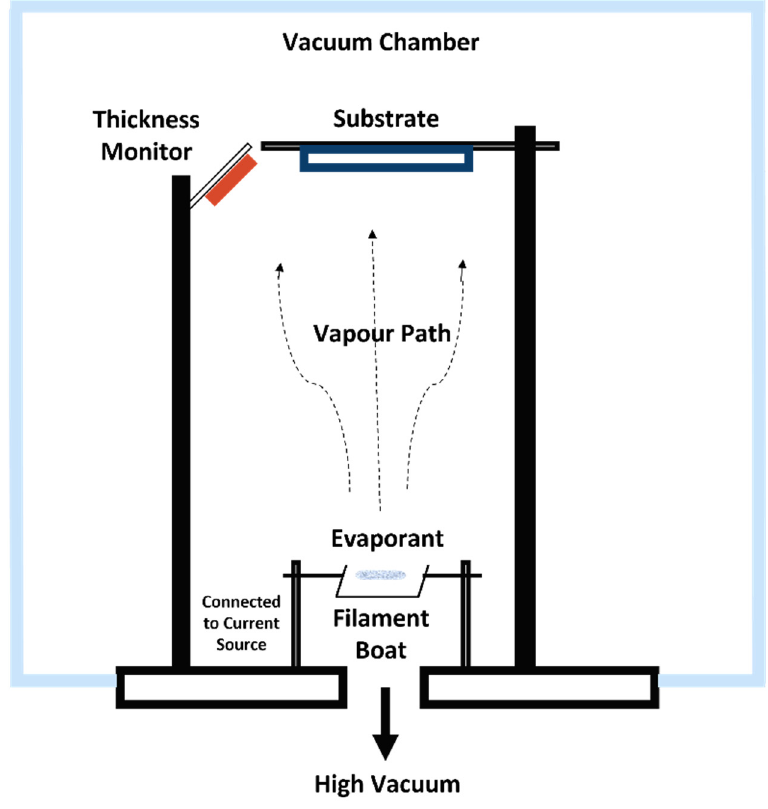
Figure 5. Thermal vacuum evaporation method.